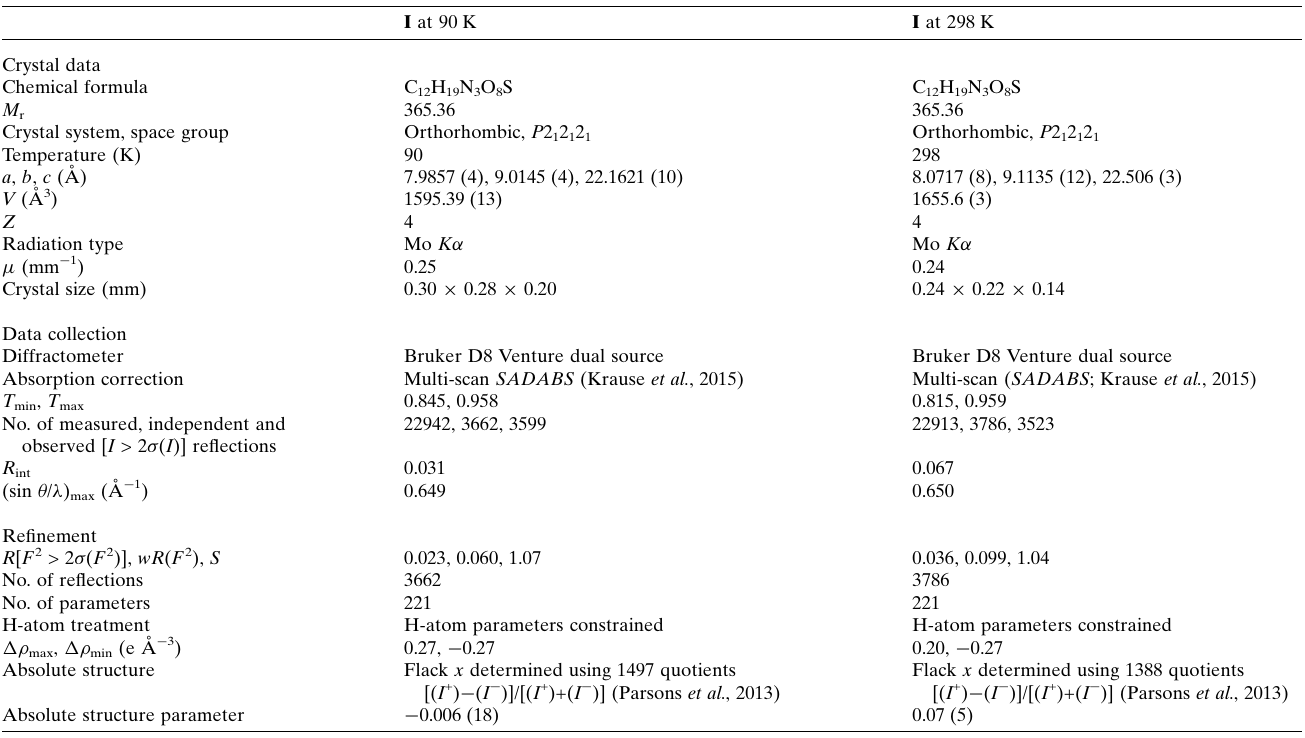
Table 4 Experimental